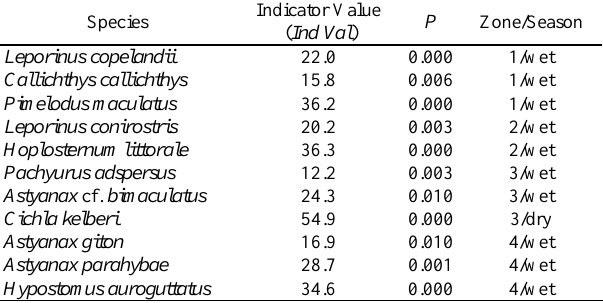
Table 3. Significant values of the Indicator Species